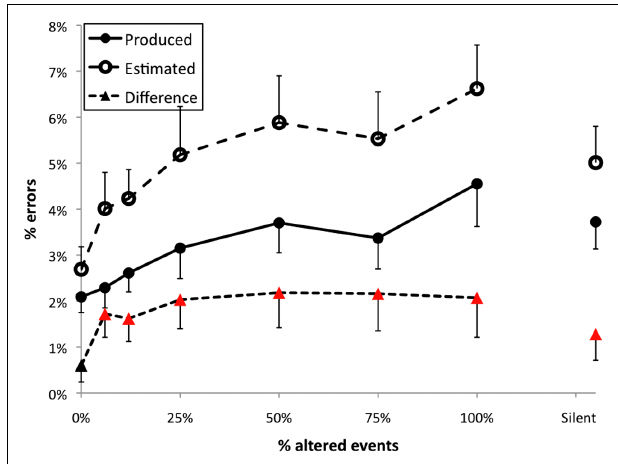
FIGURE 3 | Results from Experiment 1. Error bars indicate 1 SE of the mean; triangles plotted as red higlight those conditions for which the difference between produced and estimated error frequencies differed significantly from zero.